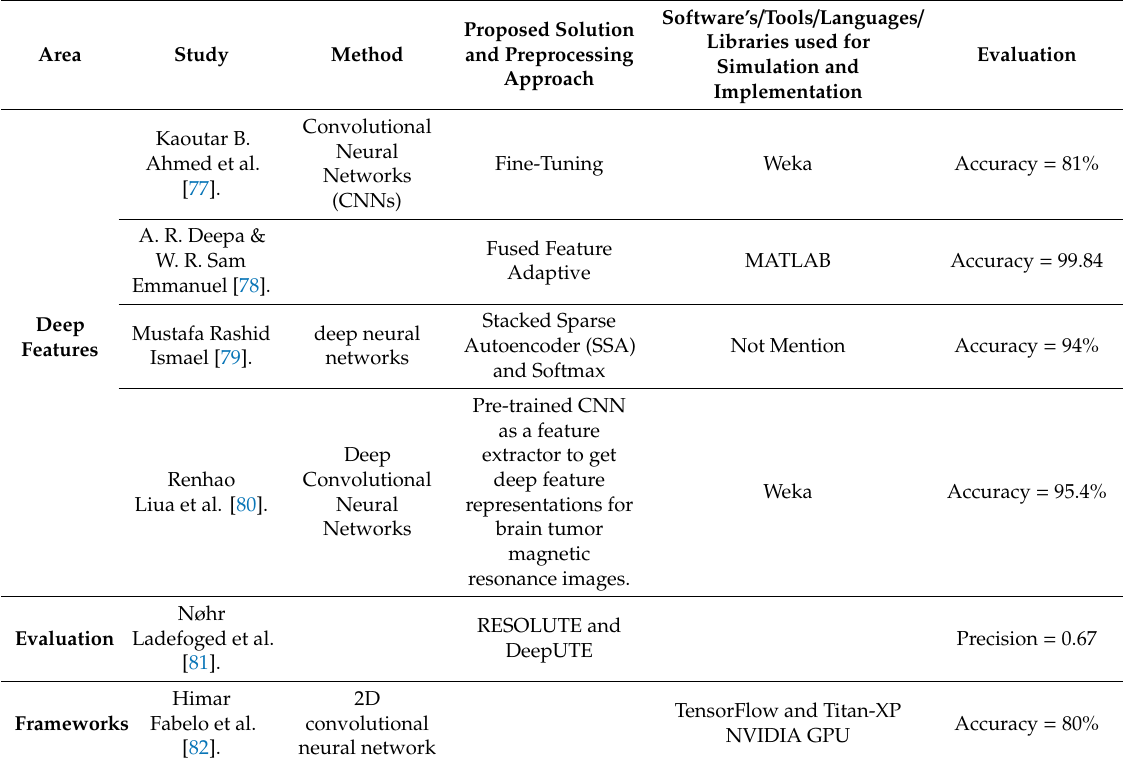
Table 4. Overview of papers using deep learning for brain tumor Deep Features, Evaluation and